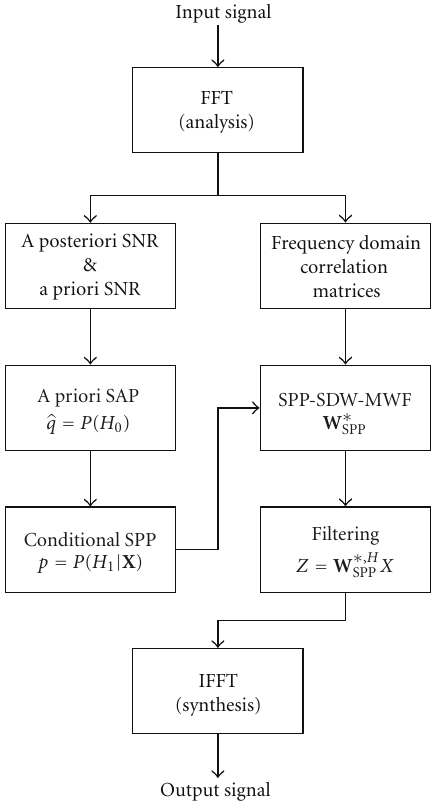
Figure 7: Block diagram of the proposed SDW-MWF SPP incorpo- rating the conditional SPP.